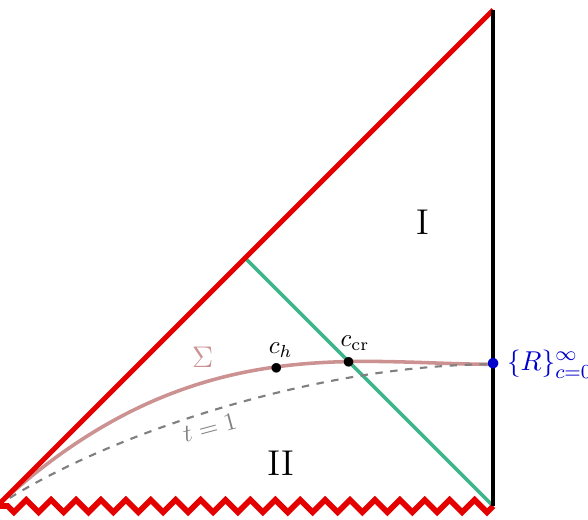
Figure 9 . Given the one-parameter family of regions f R g 1 direction, the corresponding one-parameter family of HRTs f (cid:31) R g 1 (cid:6). Its ( t; z )-projection is produced by the family of endpoints of the HRTs. The endpoint of the HRT for the critical region R lies on the green hypersurface, while for the region R of cosmological horizon size, it gets deeper into the